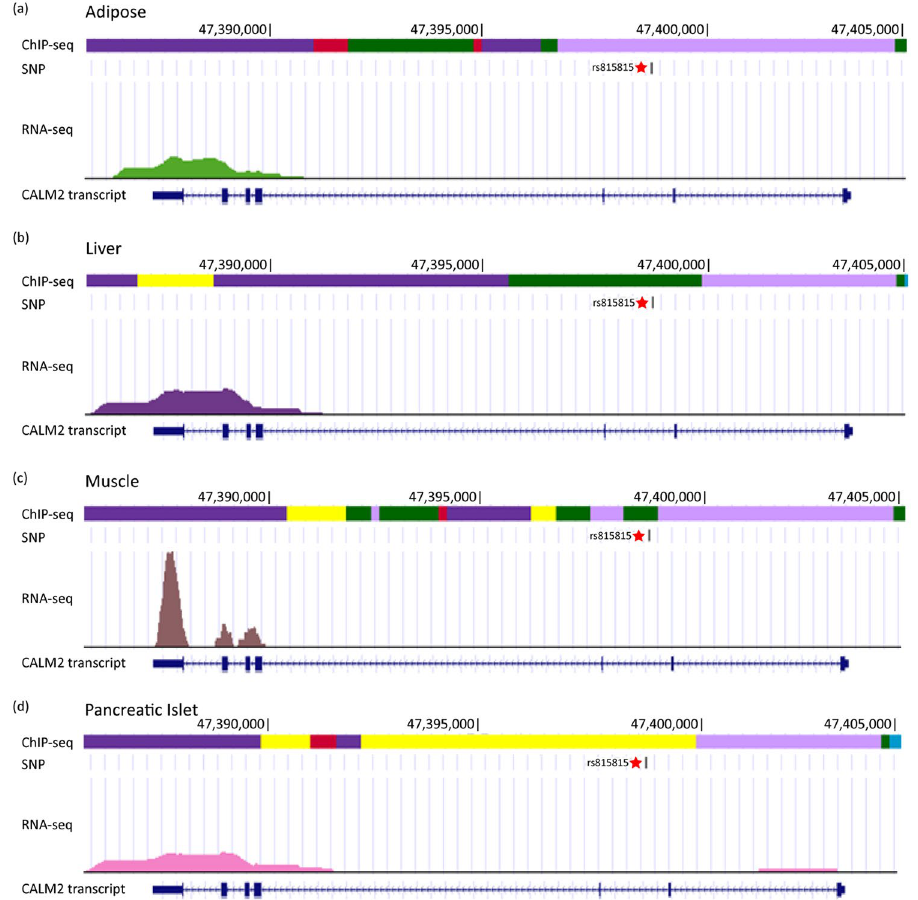
Figure 5. Genetic and epigenetic fine mapping of a newly characterized functional SNP rs815815 involved in glucose metabolism identified by iTEA. Figure 5–d show the genetic and epigenetic fine mapping of a newly characterized diabetic risk SNP rs815815 corresponding to four tissue types, adipose ( a ), liver ( b ), muscle ( c ), and pancreas ( d ). We created four annotation tracks across ‘omic’ information for each tissue. The first track is a chromatin state track based on ChIP-seq data. The second is an SNP track; SNP rs815815 is marked with a star. The third is a transcription track based on RNA-seq data. The diabetic risk variant rs815815 is located in CALM2 enhancer regions in liver, muscle and pancreas samples. In accordance with the active chromatin signal, transcription is active in all samples. Panel (e) in Fig. 3e is also the legend for panels a-d in Fig. 4. Light violet indicates active promoter regions; yellow and green indicate strong and weak enhancers,